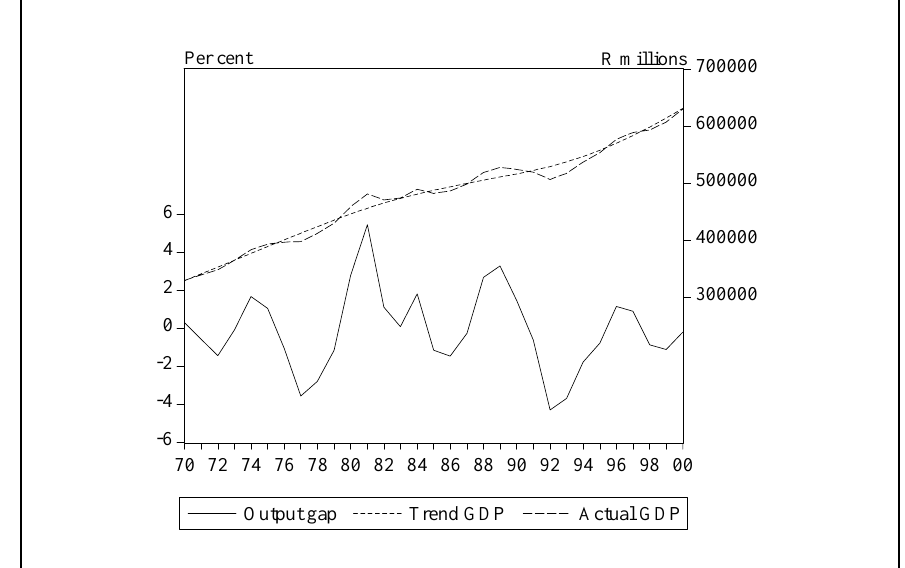
Actual real GDP, trend real GDP and the output